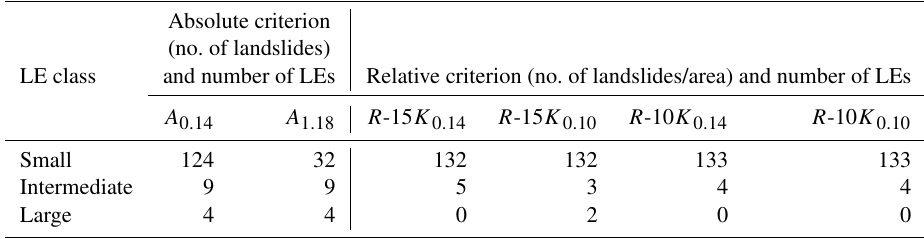
Table 7. Classification of LEs for the 6 simulations reported in Table 8.